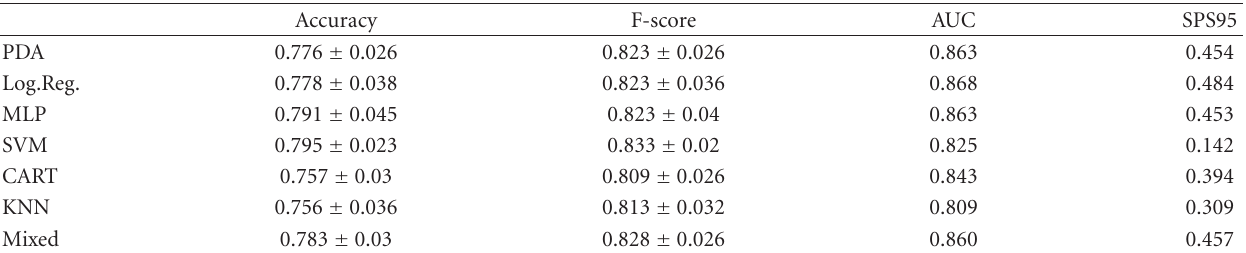
Table 2: The average performance of several classifier ensembles with respect to the validation set which was initially removed and never included in model training. We show the mean and the standard deviation values from 20 independent validation runs, no preprocessing was used.